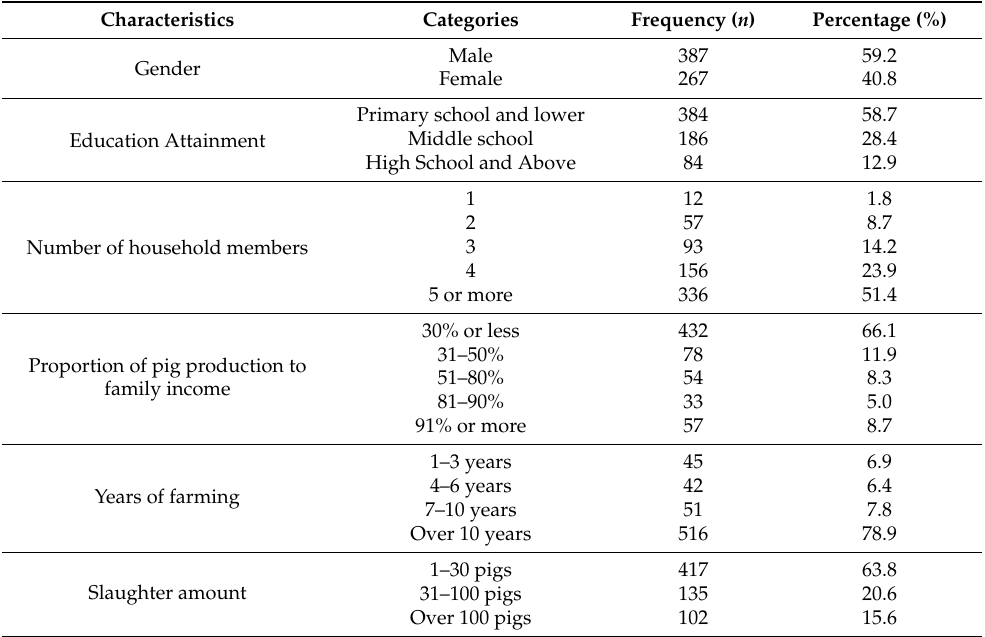
Table 2. Demographic characteristics of the surveyed farmers.